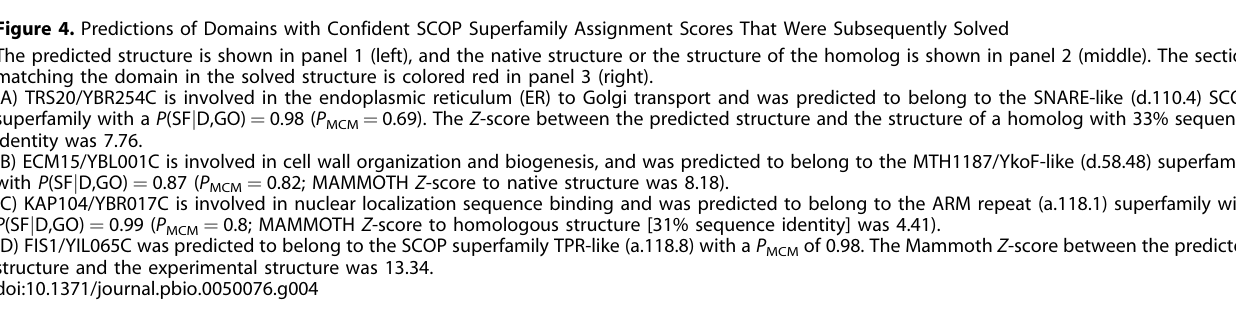
Figure 4. Predictions of Domains with Confident SCOP Superfamily Assignment Scores That Were Subsequently Solved The predicted structure is shown in panel 1 (left), and the native structure or the structure of the homolog is shown in panel 2 (middle). The section matching the domain in the solved structure is colored red in panel 3 (right). (A) TRS20/YBR254C is involved in the endoplasmic reticulum (ER) to Golgi transport and was predicted to belong to the SNARE-like (d.110.4) SCOP superfamily with a P (SF j D,GO) ¼ 0.98 ( P MCM ¼ 0.69). The Z -score between the predicted structure and the structure of a homolog with 33% sequence identity was 7.76. (B) ECM15/YBL001C is involved in cell wall organization and biogenesis, and was predicted to belong to the MTH1187/YkoF-like (d.58.48) superfamily with P (SF j D,GO) ¼ 0.87 ( P MCM ¼ 0.82; MAMMOTH Z -score to native structure was 8.18). (C) KAP104/YBR017C is involved in nuclear localization sequence binding and was predicted to belong to the ARM repeat (a.118.1) superfamily with P (SF j D,GO) ¼ 0.99 ( P MCM ¼ 0.8; MAMMOTH Z -score to homologous structure [31% sequence identity] was 4.41). (D) FIS1/YIL065C was predicted to belong to the SCOP superfamily TPR-like (a.118.8) with a P MCM of 0.98. The Mammoth Z -score between the predicted structure and the experimental structure was 13.34.